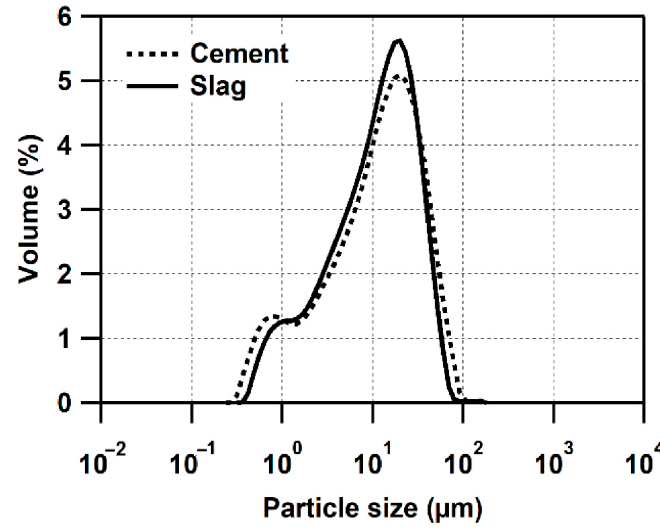
Figure 1. Particle sized distribution of slag used in this study.